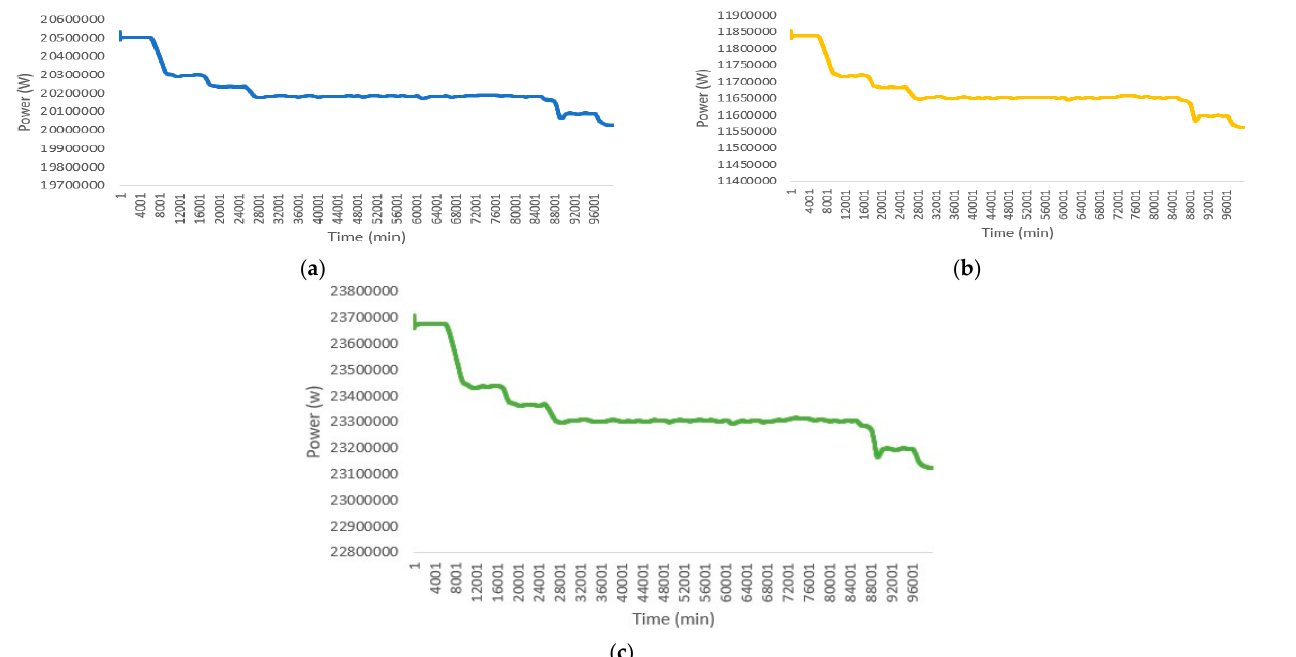
Figure 19. Generator active ( a ) reactive ( b ) and apparent power ( c ). Simulation results for condenser model simulation and validation are represented by Figure 20.